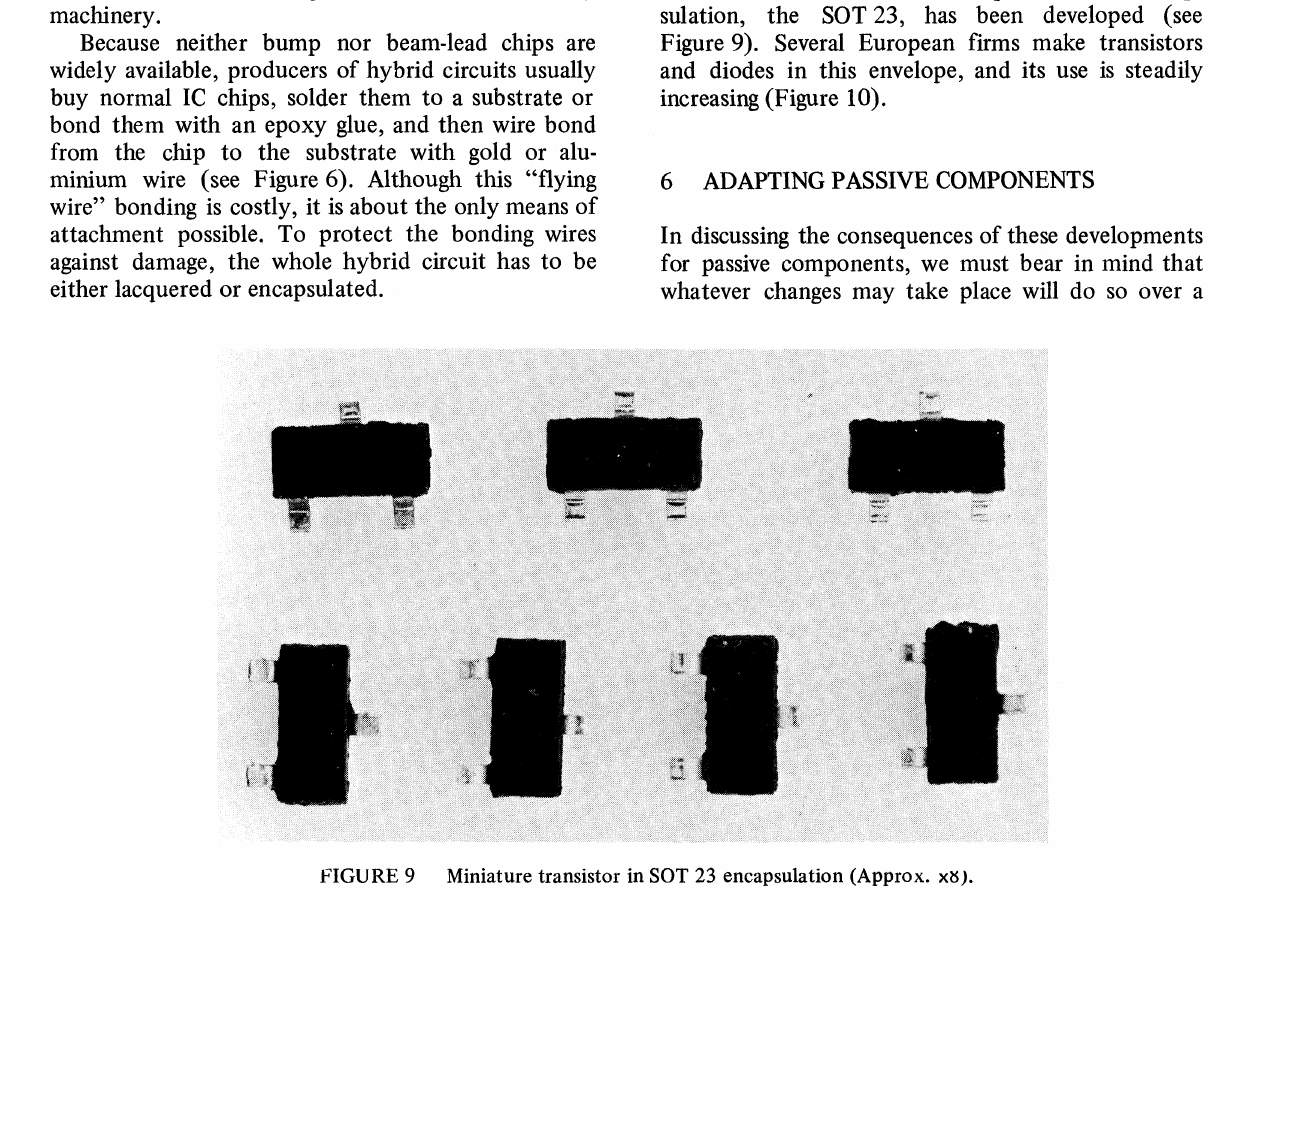
FIGURE 8 Integrated circuit chip mounted on polyimid film, to be used on reels (Approx. xl.6).